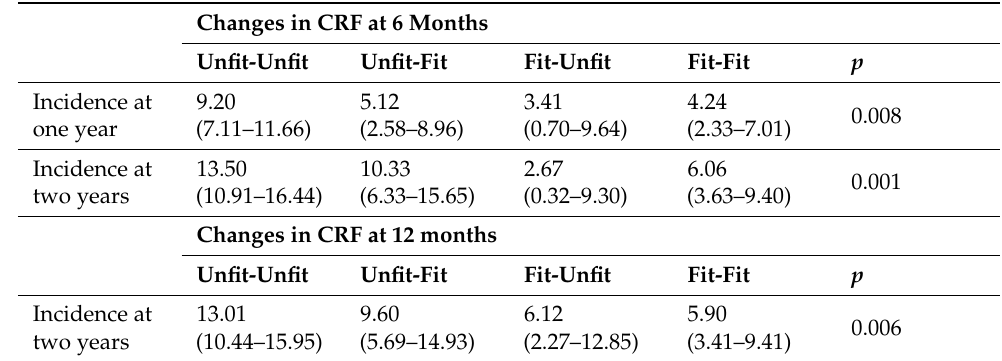
Table 3. Cumulative incidence rates of abdominal obesity across unfit-unfit, unfit-fit, fit-unfit, and fit-fit groups of change at 6 months and 12 months.